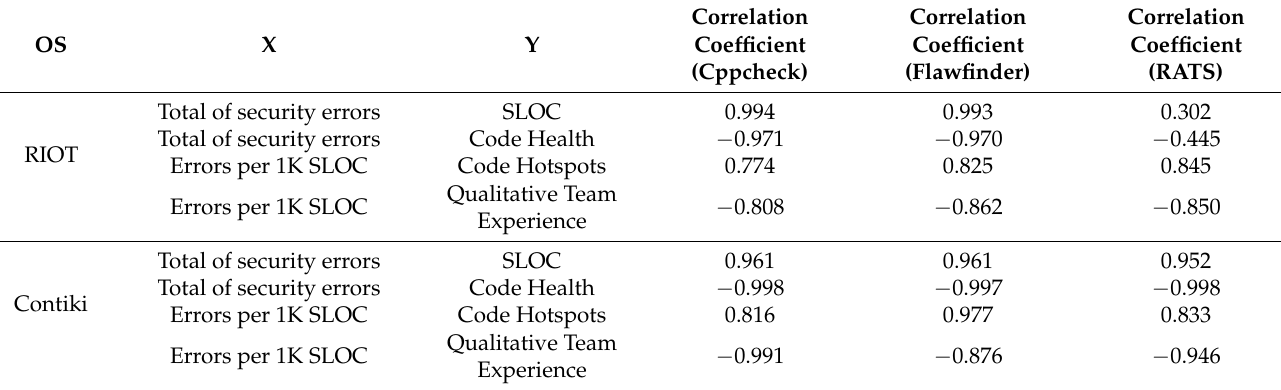
Table 13. Correlation coefficient of evolutionary properties and the presence of IoT OS